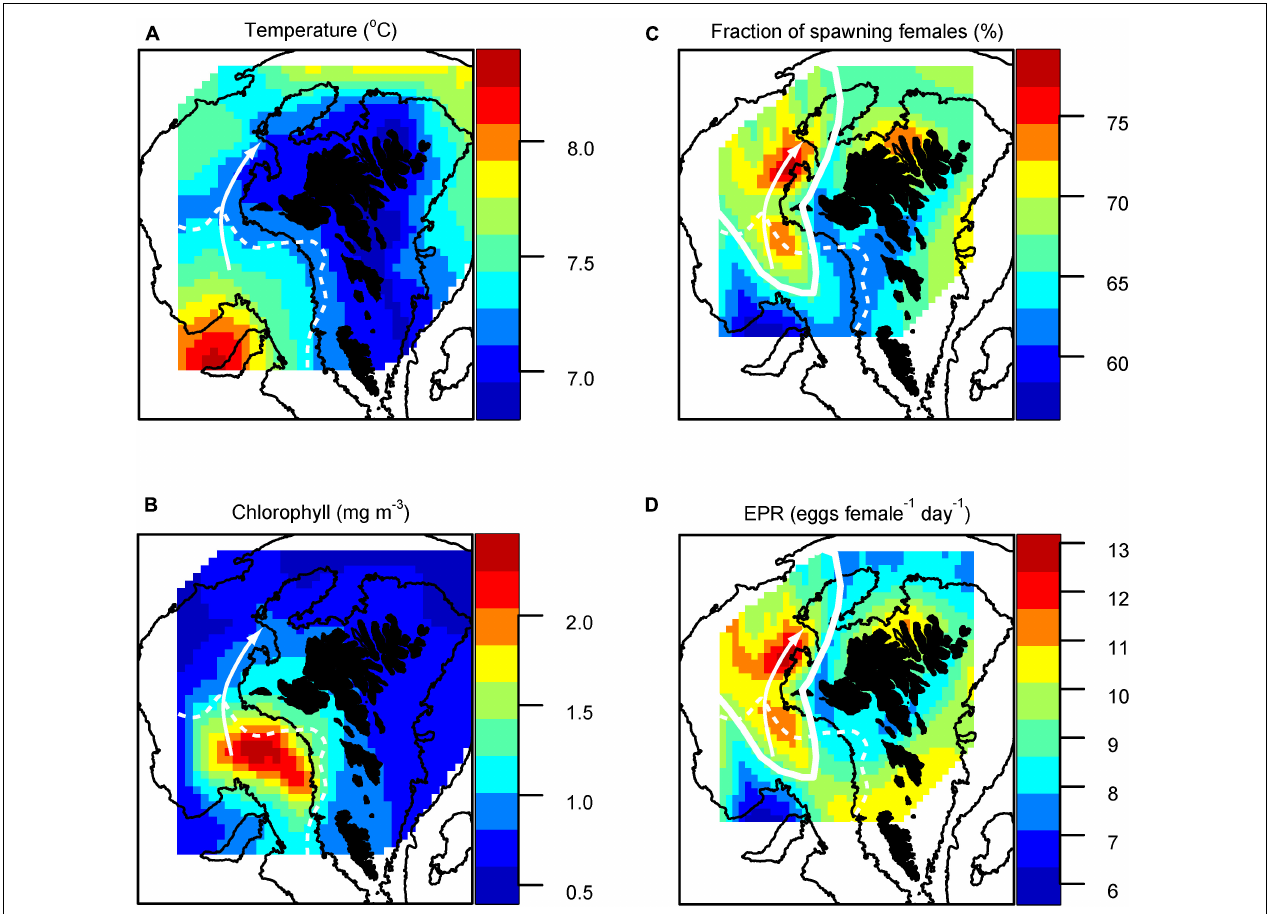
FIGURE 2 | Mean (1997–2020) distribution in (A) temperature, (B) chlorophyll, (C) C. finmarchicus spawning fraction and (D) individual egg production rates (eggs female − 1 day − 1 ) in the uppermost 50 m on the Faroe Shelf in late April. The dashed curves illustrate the typical position of the tidal front between the WR and the inner shelf, and the white arrows represent the inflow region. The white full line in (C,D) shows the domain of the north-western area, averaged to produce the time series in Figure 4 . Yearly distribution maps are provided in Supplementary Material